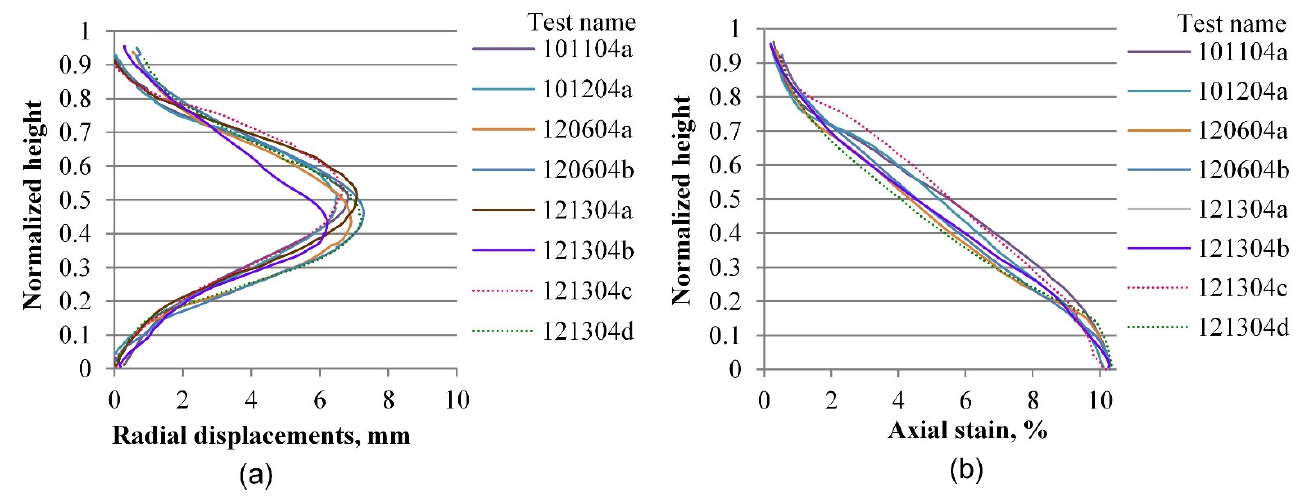
Figure 26. Vertical profiles of averaged displacements at 10.0% of the axial strain of sand specimens prepared by the dry pluviation method: radial displacements ( a ) and vertical displacements ( b ).